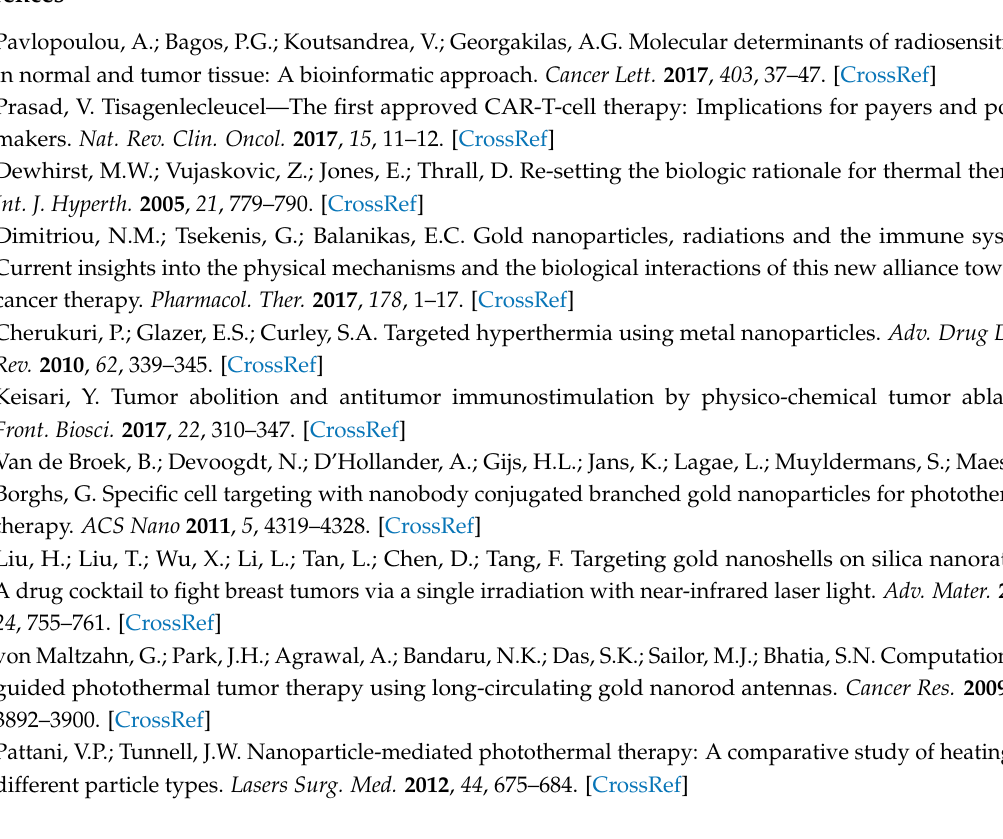
Figure S1. HSP90 interactome; confidence score of interactions more than 90%. The nodes represent genes/proteins and the lines indicate connection between nodes. The molecular action visualization mode was